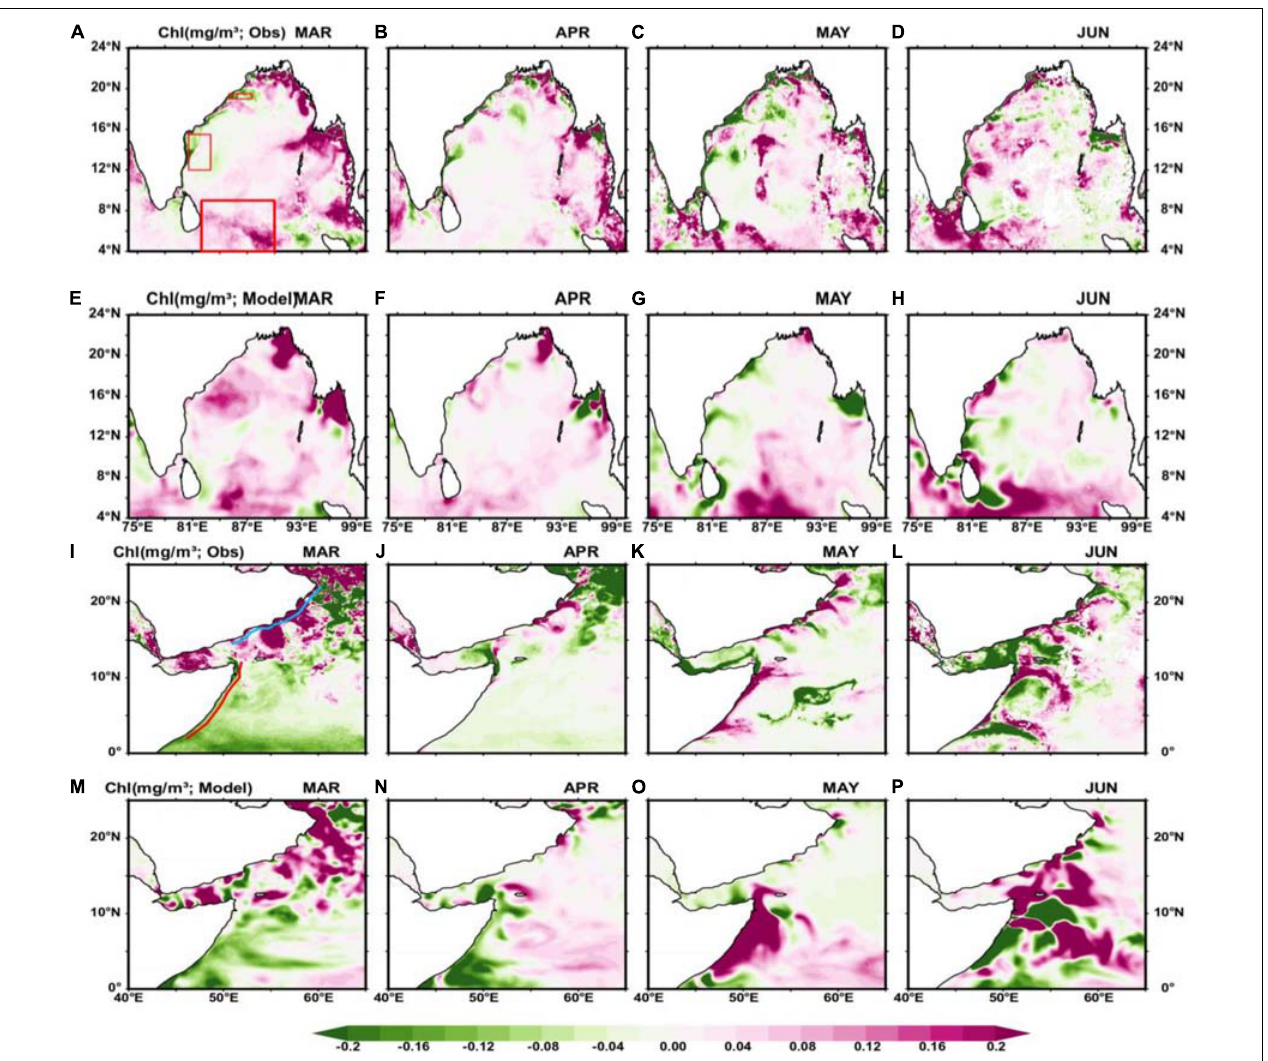
FIGURE 2 | Chlorophyll-a (Chl-a) concentration difference (milligram per cubic meter) from pandemic period (March–June of 2020) to pre-pandemic period (March–June of 2019) from the observations (rows 1 and 3) and model simulations (rows 2 and 4) over the BoB (rows 1 and 2) and western Arabian Sea (WAS) (rows 3 and 4). The red rectangular boxes [in panel (A) ] are chosen for the vertical profile analysis, and the red (sky blue) continuous line [in panel (I) ] represents the 1,000 m isobath section in Somalia (Oman) coast used to study the vertical